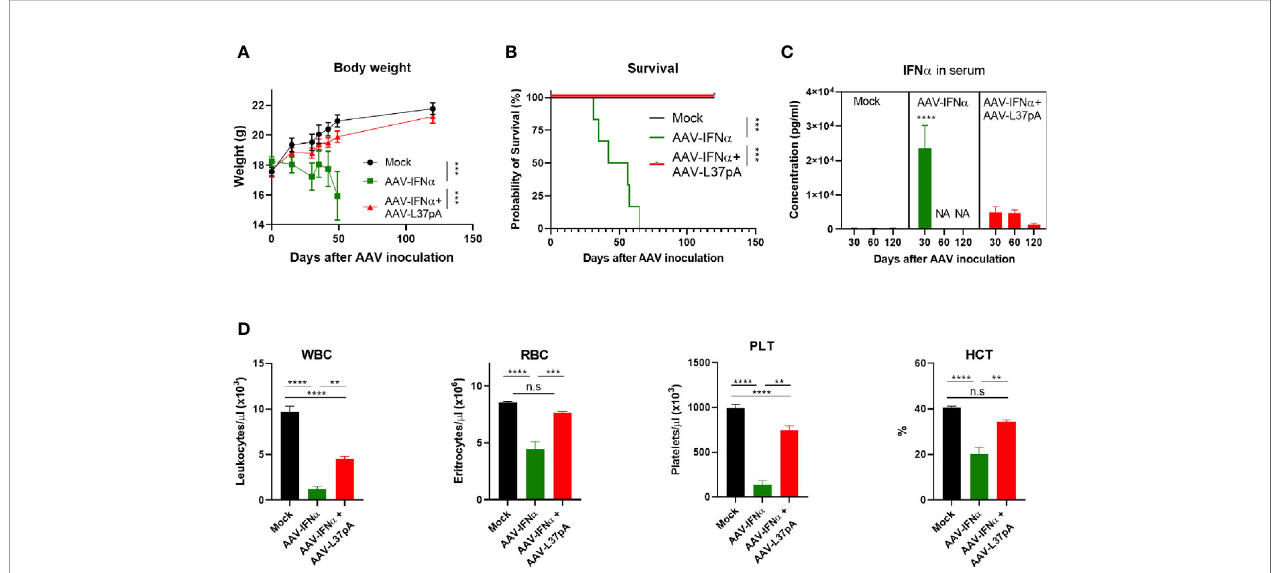
FIGURE 1 | Coadministration of AAV-L37 avoids the lethal toxicity induced by AAV-IFN a . C57BL/6 mice (N = 6) were left untreated (Mock) or received 1.2x10 11 vg/ mouse of AAV-IFN a alone (AAV-IFN a ) or combined with 9.5x10 11 vg/mouse AAV-L37pA and the body weight (A) and survival (B) was followed up for 120 days. At day 30, 60, and 120, serum levels of IFN a were determined by ELISA (C) and complete blood counts were analyzed with a Hemavet Hematology Analyzer. (D) WBC, white blood cells; RBC, red blood cells; PLT, platelets; HCT, hematocrit. Mean ± SEM is represented. **p < 0.01 ***p < 0.001 ****p < 0.0001. Body weight was analyzed by Extra Sum-of-Square F test after non-linear regression with a third order polynomial least square fi t. Survival was analyzed by Log-Rank test. IFN a concentrations were analyzed by nested one-way ANOVA followed by Dunnett ’ s multiple comparisons test. **** indicate p < 0.0001 for AAV-IFN a compared to the other two experimental groups. Red blood counts were analyzed by one-way ANOVA followed by Tukey ’ s multiple comparisons